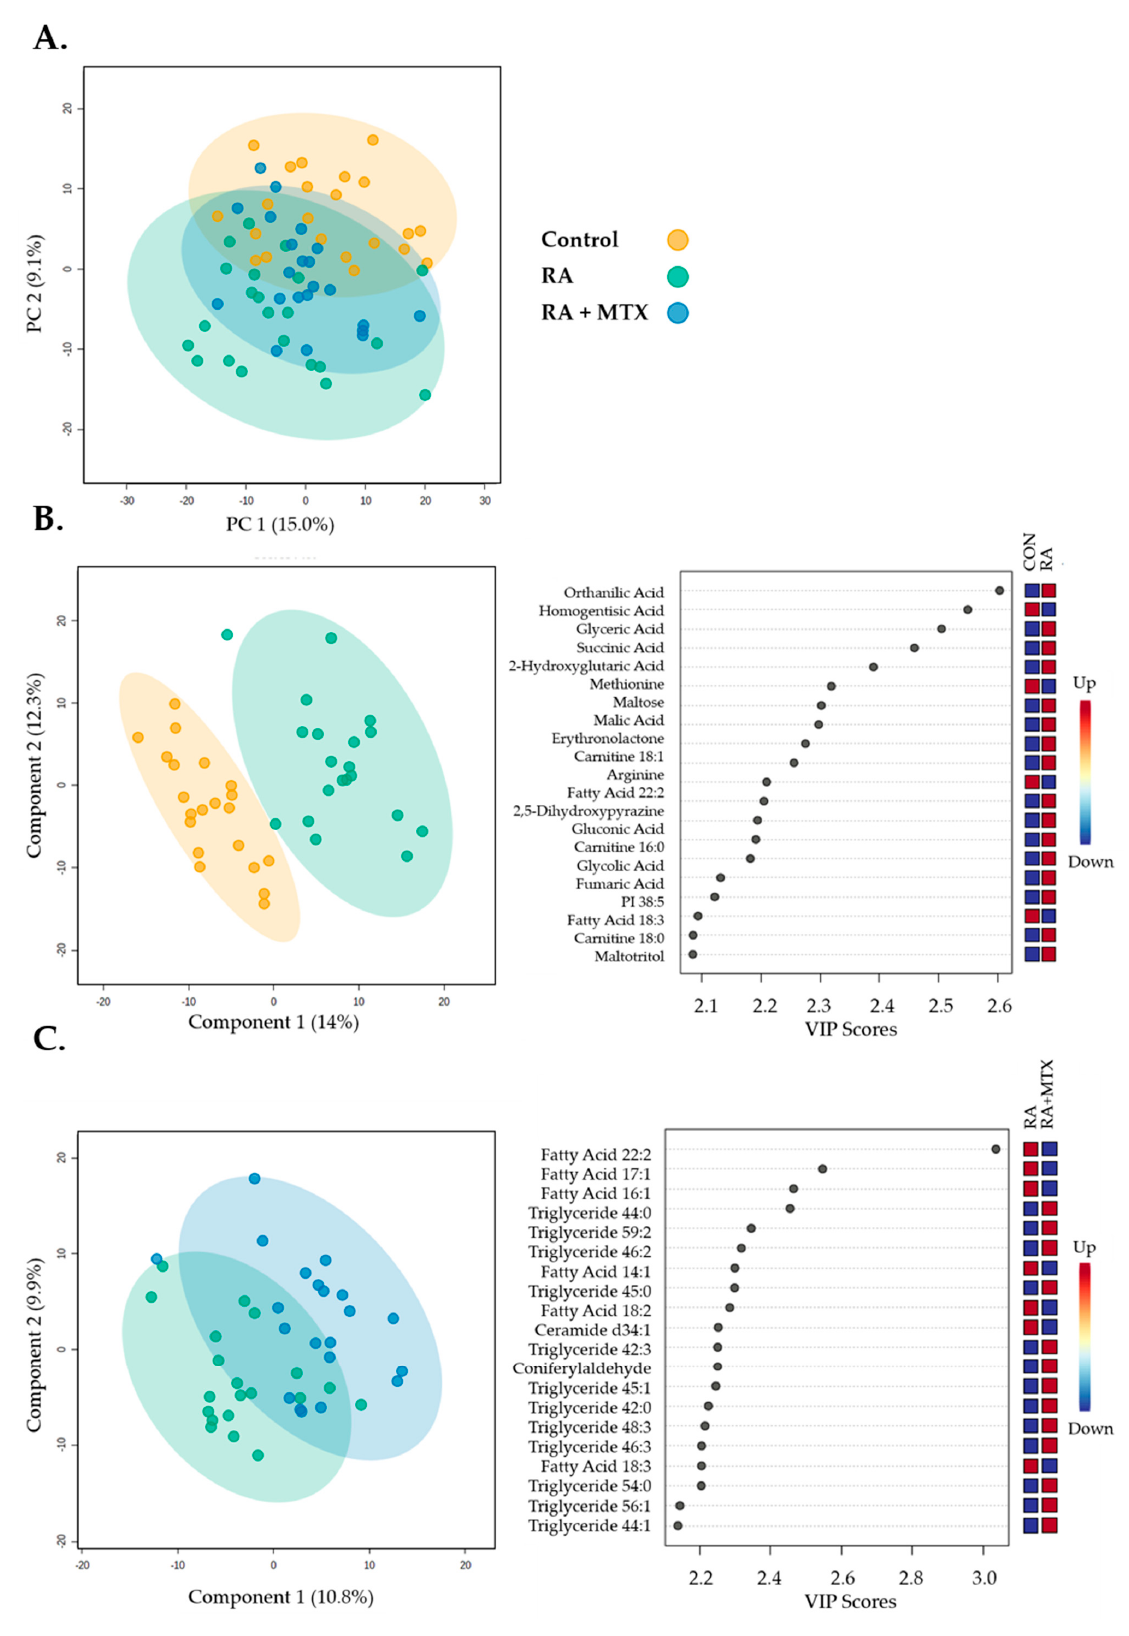
Figure 1. Multivariate unsupervised and supervised analysis of 647 metabolites identified from individual patient samples providing 2D score plots displaying principal components within the healthy control subjects (control, yellow), RA